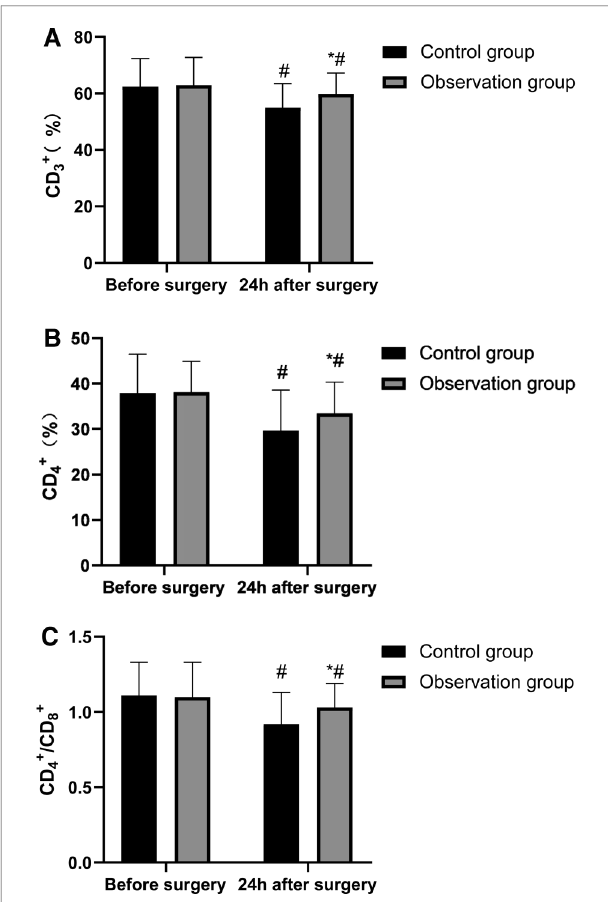
FIGURE 4 | Comparison of T lymphocyte subsets between two groups. Note: Compared with the control group, * p <0.05; Compared with the same group before surgery, * p <0.05.